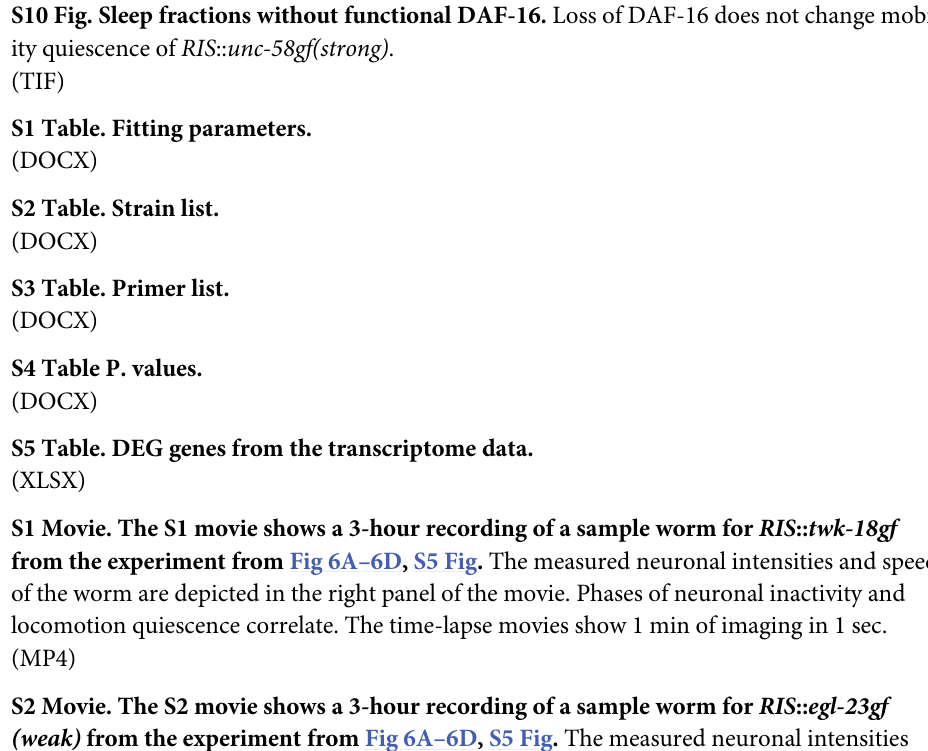
S8 Fig. Pharyngeal pumping rates. The pumping rate of RIS :: unc-58gf(strong) in arrested L1 worms is comparable to the wild type. S9 Fig. Characterization of the RIS :: unc-58gf(strong) , flp-11(-) strain. A) The UNC-58gf channel is still expressed at the plasma membrane of RIS in RIS :: unc-58gf(strong) , flp-11(-) . B) flp-11(-) causes strongly reduced recovery rates (Fisher’s Exact Test was conducted on day 18) for comparisons when flp-11(-) was the shortest lived condition, day 20) when RIS :: unc-58gf (strong) , flp-11(-) was the shortest-lived condition or day 24) when wild type was the shortest- lived condition. The p-values were FDR corrected with Benjamini-Hochberg procedure with a 5% false discovery rate. The plot includes data from three replicates. ��� p < 0.001. S10 Fig. Sleep fractions without functional DAF-16. Loss of DAF-16 does not change mobil- ity quiescence of RIS :: unc-58gf(strong)